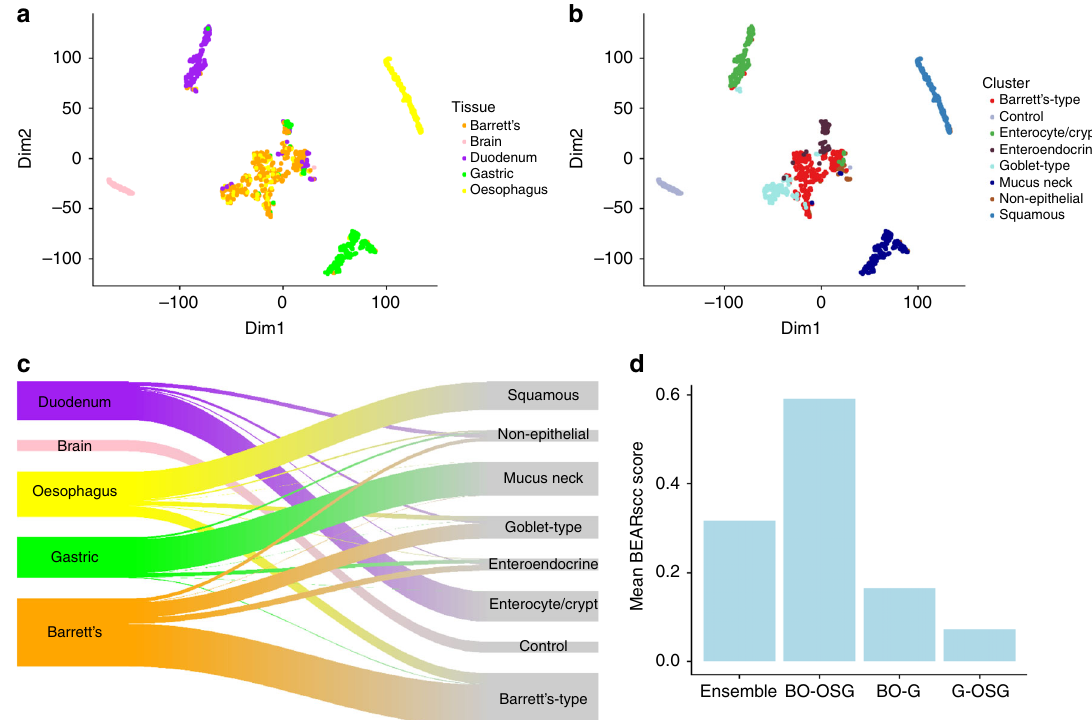
Fig. 3 The majority of Barrett ’ s oesophagus cells have a similar transcript pro fi le to oesophageal submucosal gland (OSG) cells. a t-Distributed Stochastic Neighbour Embedding (t-SNE) plots of cells from all samples from four BO patients ( n = 1107 including brain control), showing similarity of cells in two dimensions, coloured by tissue type (yellow, oesophagus; green, gastric cardia; purple, duodenum; orange, Barrett ’ s oesophagus; pink, brain). Brain was used as a control. b t-SNE plot of cells from four BO patient samples ( A – D) , as in a , coloured by how cells contribute to clusters generated by SC3 analysis with 250 repeat clusterings of simulated technical replicates (see Methods). Names given to the clusters are based on expression of known marker genes (see text and Supplementary Fig. 3). c Sankey diagram showing how each tissue type sampled contributes to the clusters shown in b . Colours and labels on the left indicate sampled tissue (as in a ); colours and labels on the right indicate cluster (as in b ). d Mean BEARscc score for each grouping of ‘ gland-like ’ cells ( n = 372), which are a sub-set of gastric (G, n = 175), BO ( n = 78) and OSG cells ( n = 119): excluding gastric and BO cells that expressed CHGA or MUC2 (to exclude enteroendocrine and goblet cells, respectively) and excluding oesophageal cells that did not express TFF3 (to exclude squamous cells). ‘ Ensemble ’ refers to all cells grouped together. Thresholds were set at the tenth centile of cells in which at least one transcript was detected from each